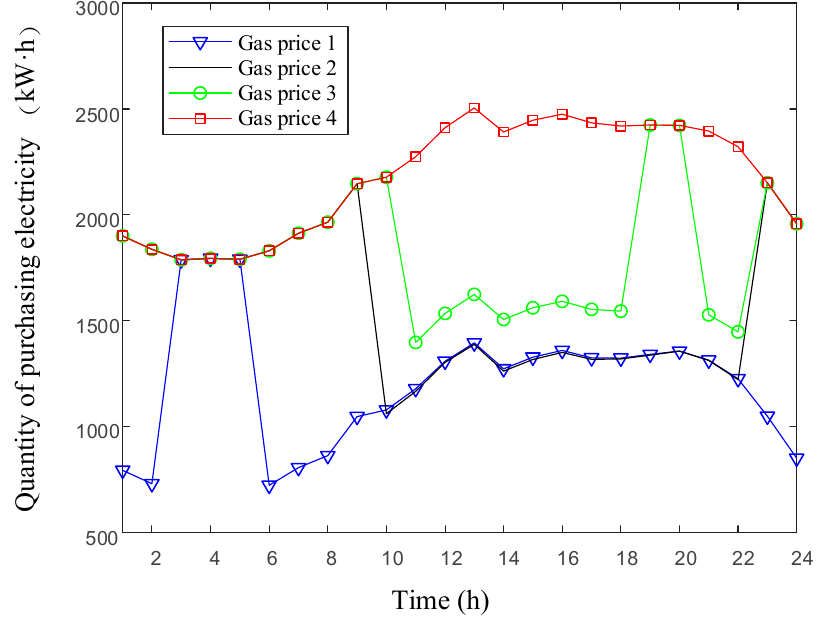
Figure 16. Quantity of purchasing gas for different gas prices in stage 3, typical day 2. From the gas price 2 curve and the benchmark natural gas price curve of Figure 17, the gas price 2 is lower than the benchmark natural gas price during 10 h to 22 h, indicating that the actual gas price is lower, and the gas turbine generates at this time. Therefore, the quantity of purchasing electricity of gas price 2 in Figure 15 reaches the minimum, and the quantity of purchasing gas of gas price 2 in Figure 16 reaches the maximum. For other moments, gas price 2 is higher than the benchmark natural gas price, indicating that the actual gas price is higher, and the gas turbine does